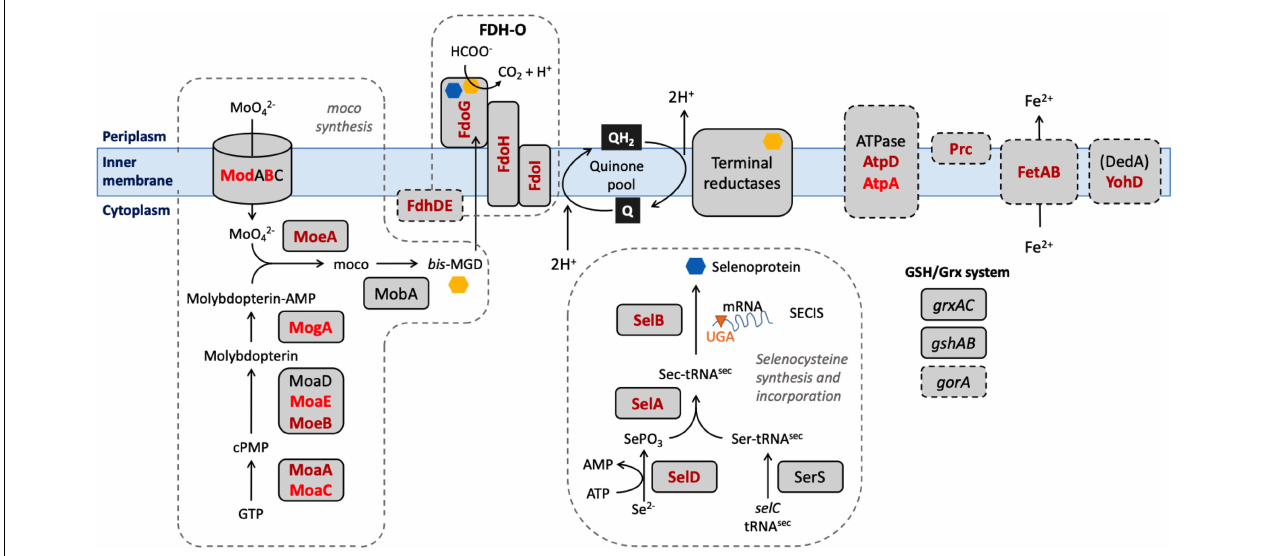
FIGURE 8 | Selected biological pathways where the “loss of fitness” genes are involved. Dashed boxes include biological pathways and genes which were shown to be significantly affected after the exposure to honey. Mo cofactor and selenocysteine, being incorporated into the 3 FDHs after the biosynthesis, are denoted by yellow and blue polygons, respectively. Genes found in both lists are shown in dark red; genes found only in the TL30 list are shown in light